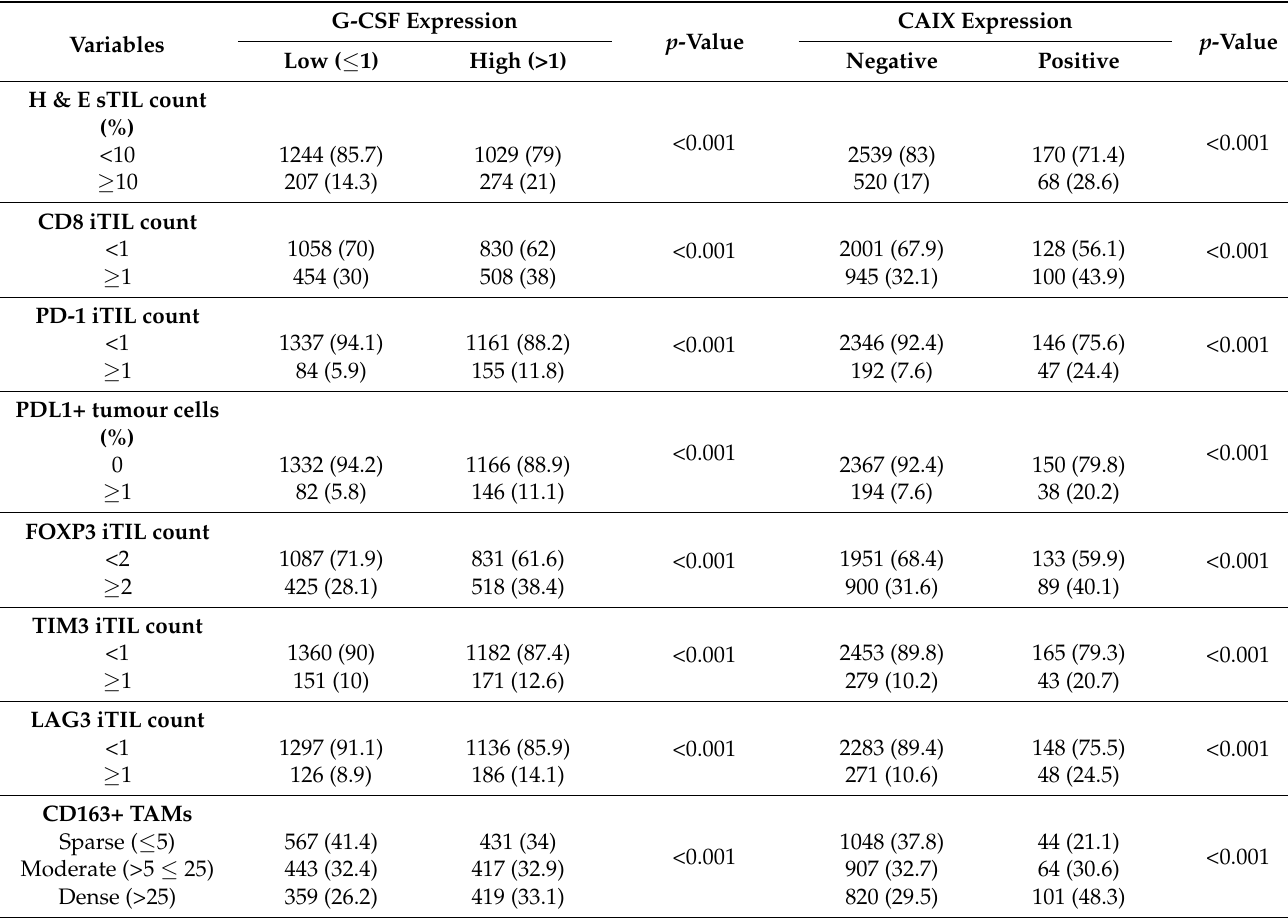
Table 2. Correlation of immune biomarkers with G-CSF and CAIX expression (whole cohort)